Question: Looking at the figure, what chart type is it?
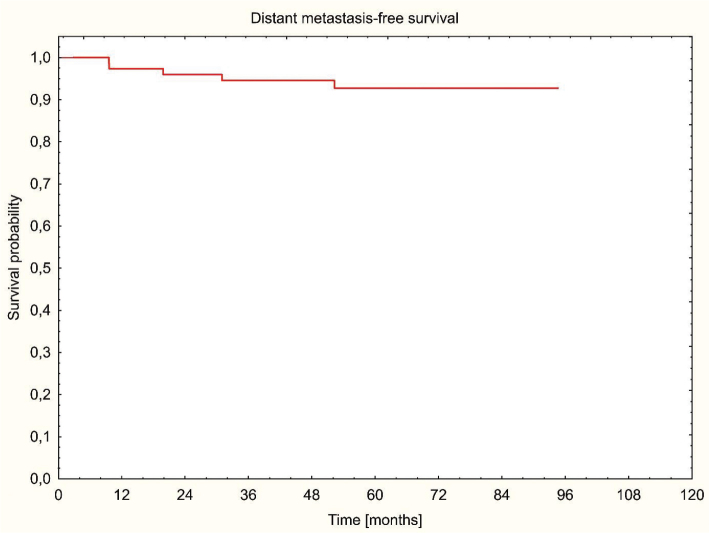
Answer: survival